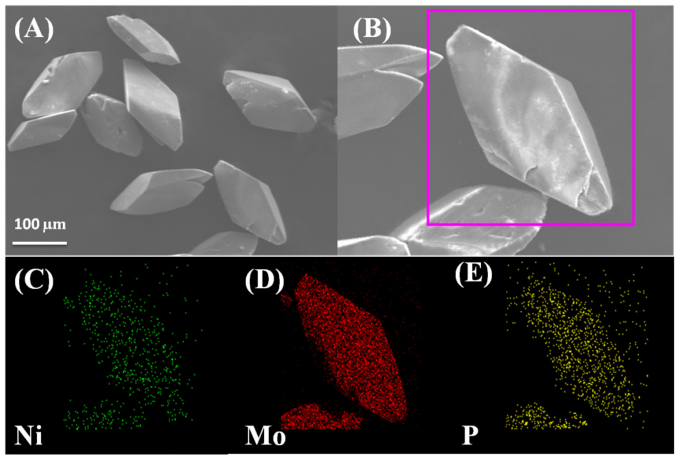
Figure 4. ( A , B ) The SEM image of 1 (the pink box represents the selected region). ( C – E ) The SEM elemental mappings of Ni, Mo, and P in 1 .